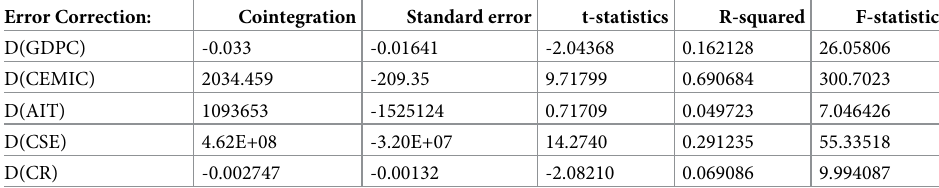
Table 13. Vector error correction